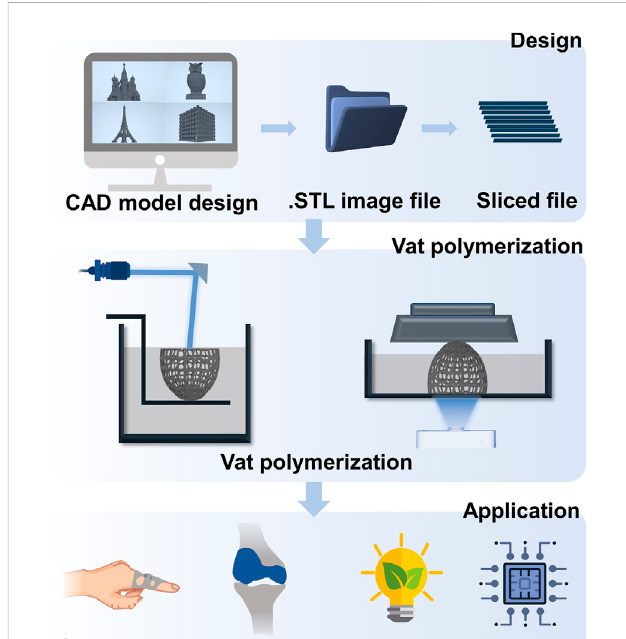
FIGURE 2 Schematic illustration of the vat polymerization process, from design to